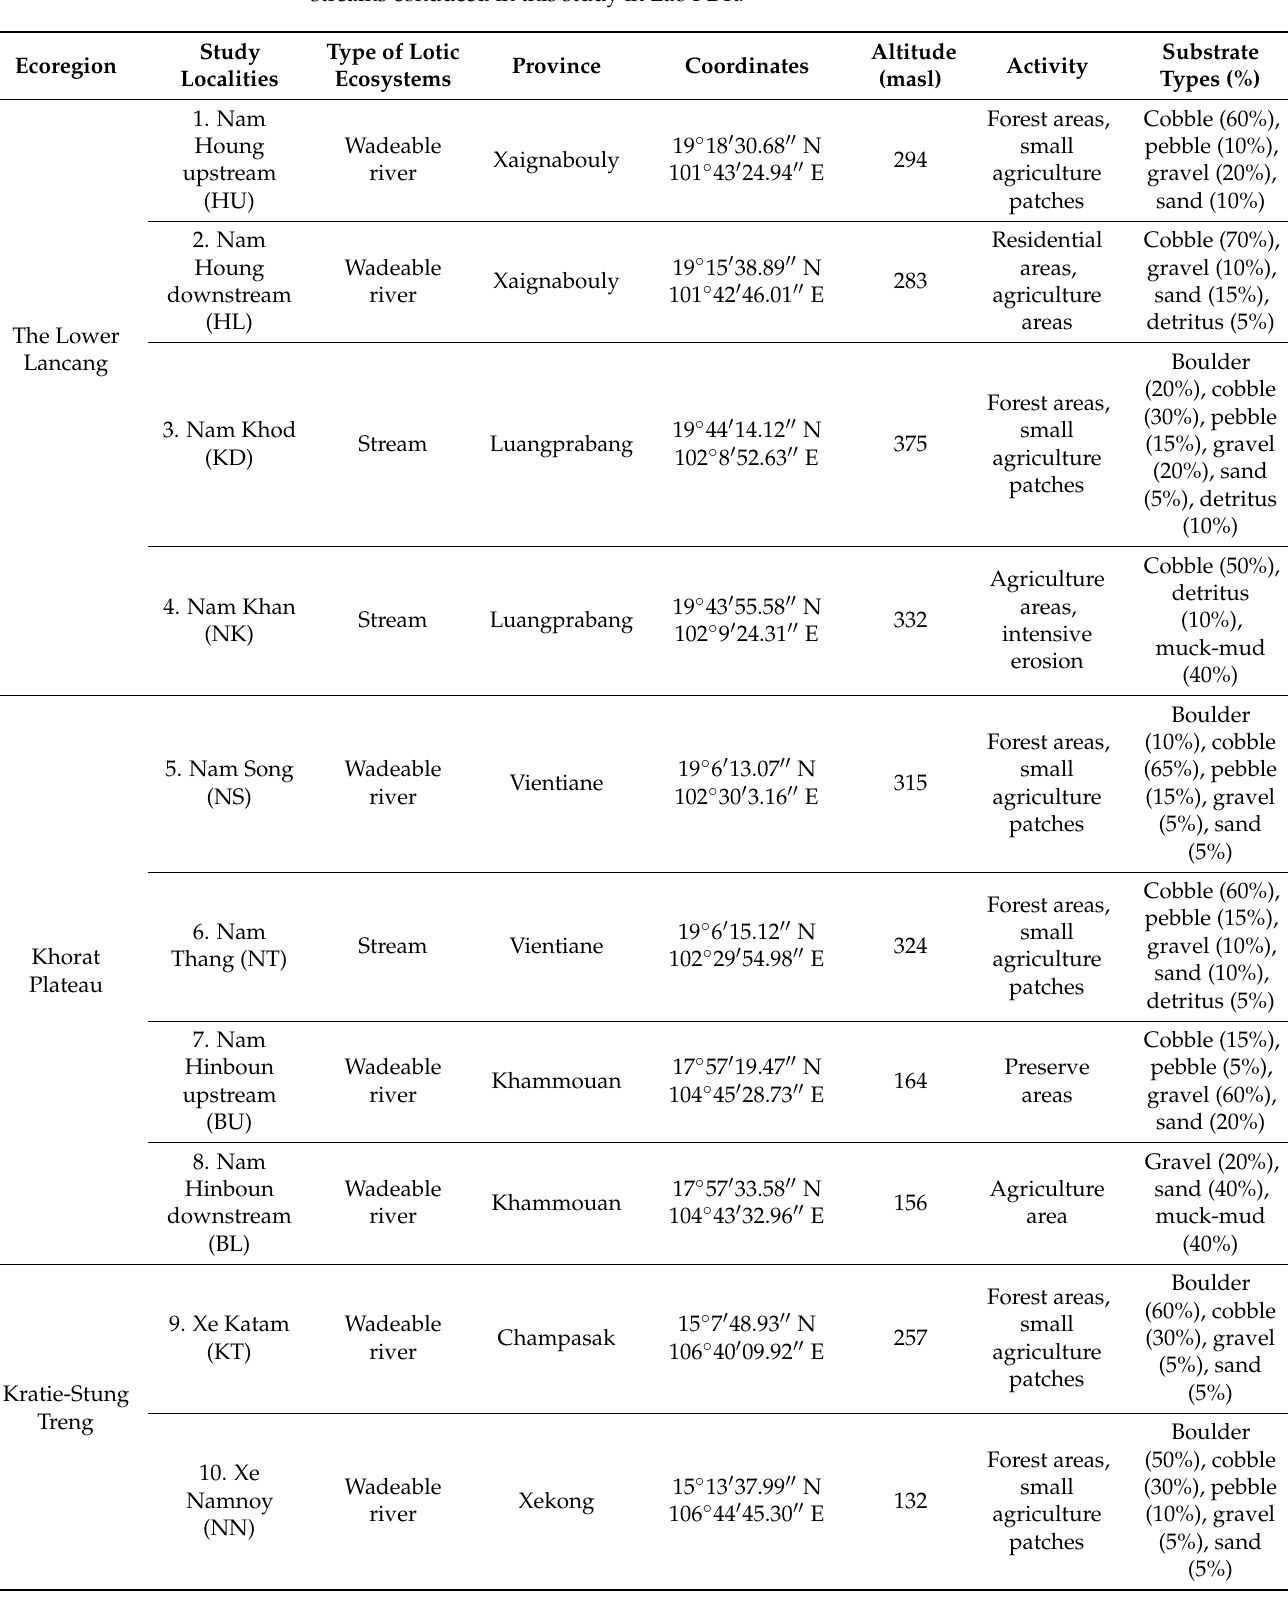
Table 1. General characteristics and geographical position of 10 localities of wadeable rivers and streams conduced in this study in Lao